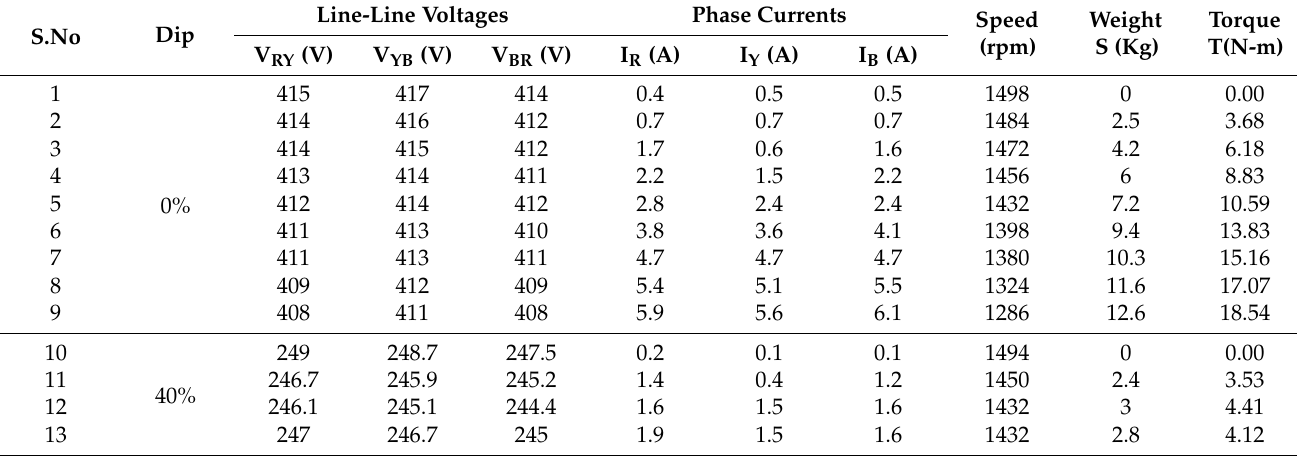
Table 6. Star connected (non-neutral) three-phase induction motor under loaded